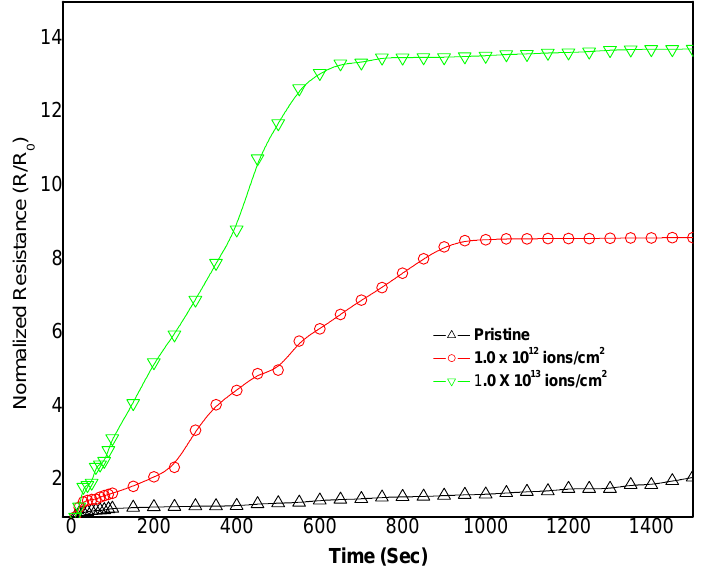
Figure 4. Electrical response of composite films to 1000 ppm of ammonia